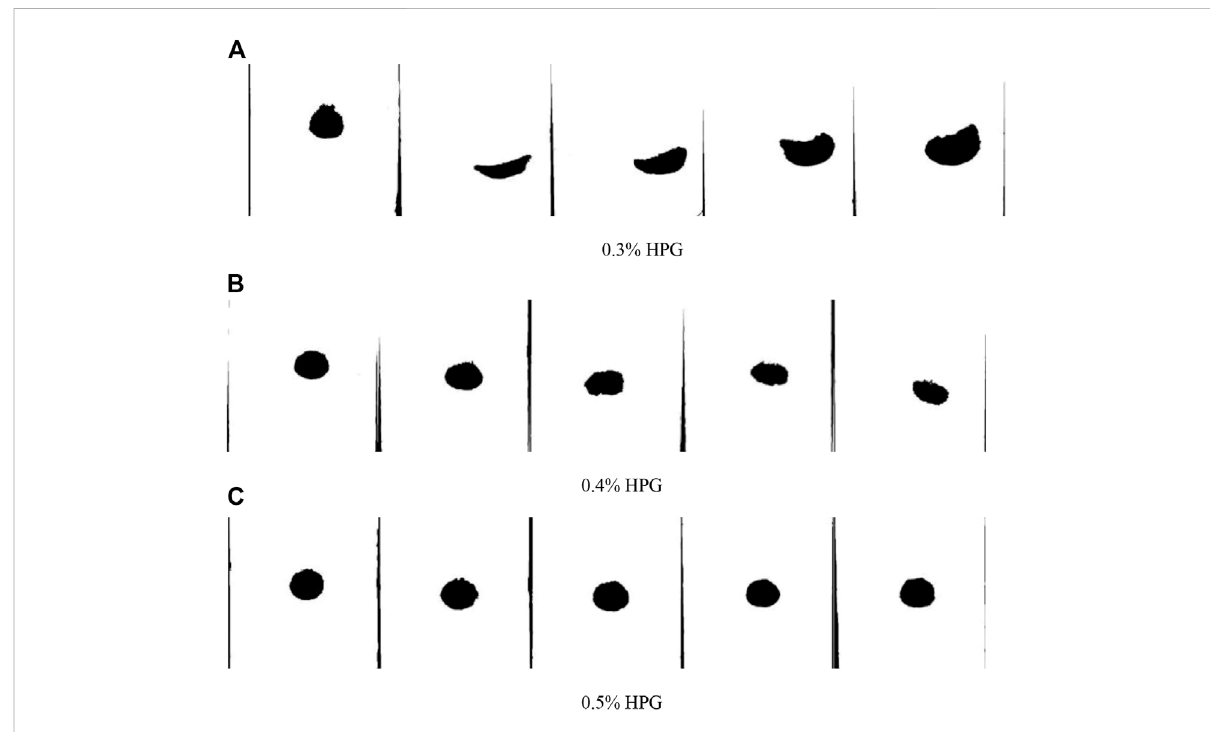
FIGURE 12 Shape change rules of 0.5% fi ber-containing cluster. (A) 0.3% HPG, (B) 0.4% HPG, (C) 0.5%